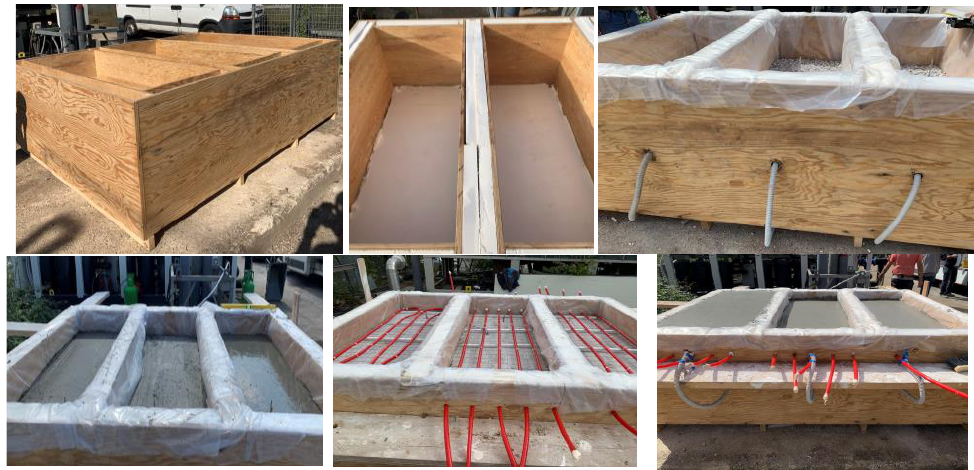
Figure 4. Some phases of the installation of the RTC Box.